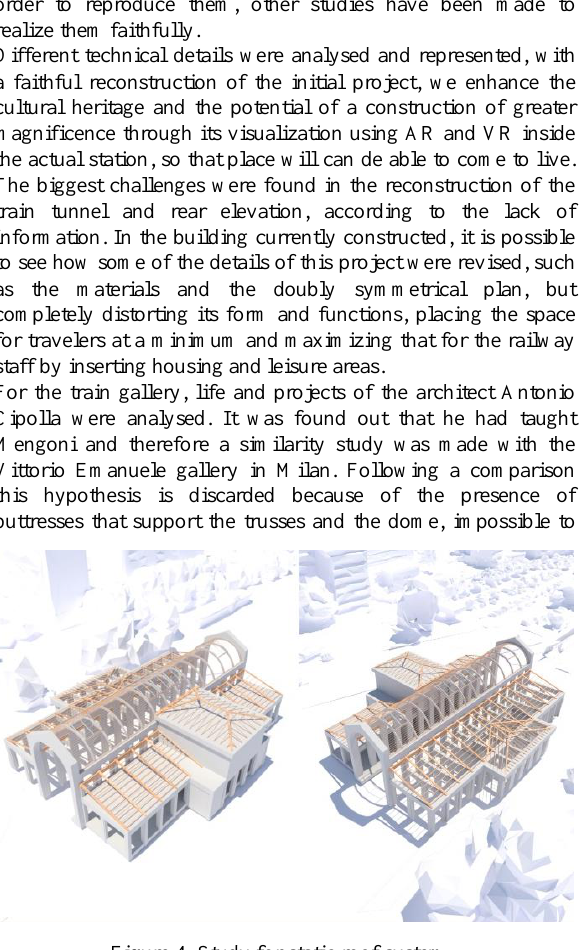
Figure 4. Study for static roof system